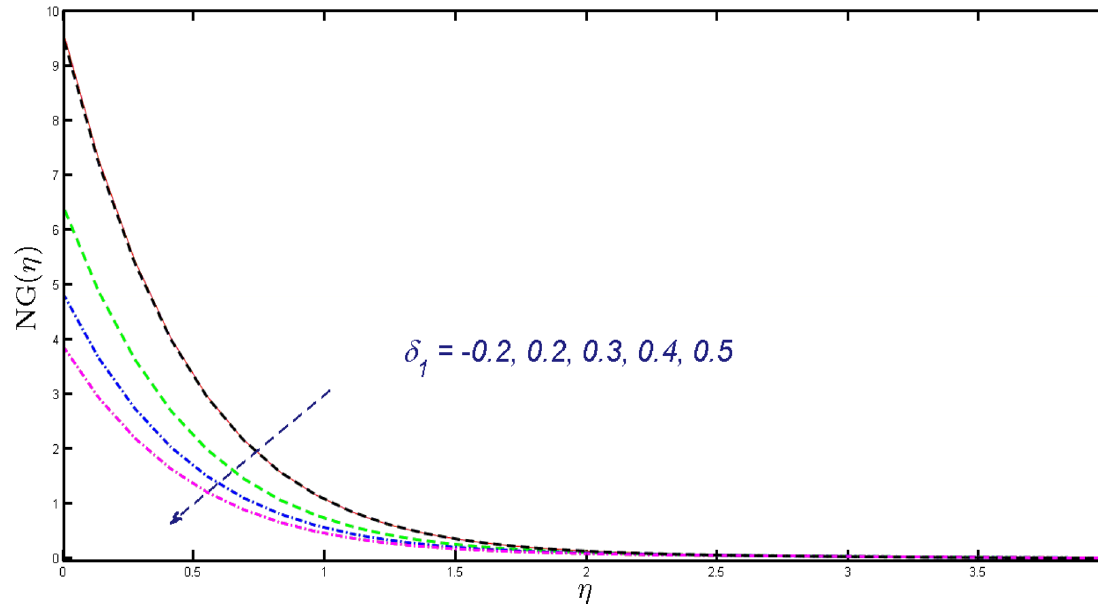
Figure 25. Upshot of NG (η) for δ 1 .